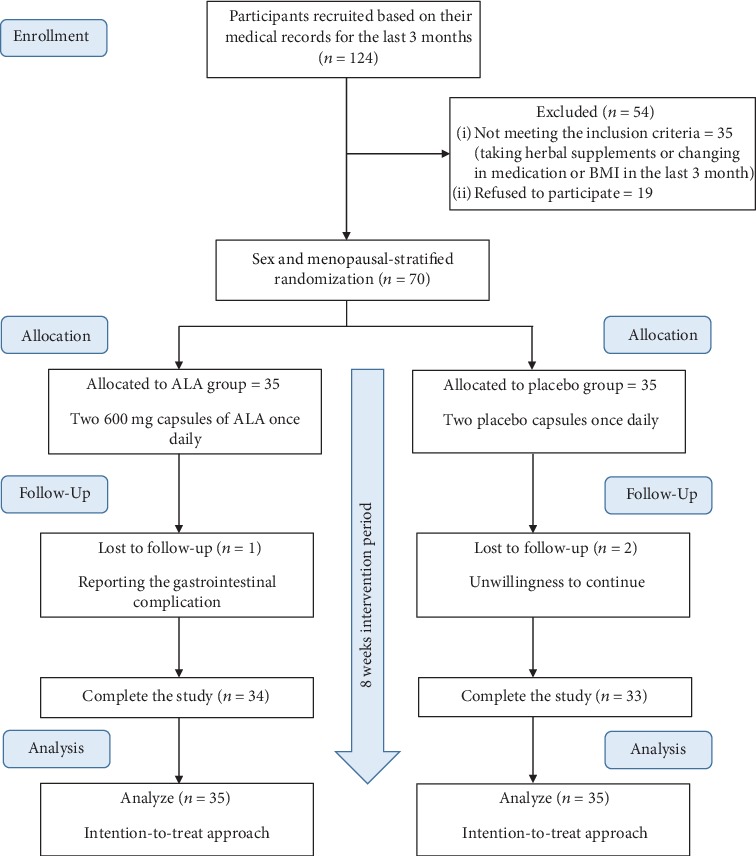
Study flow chart.